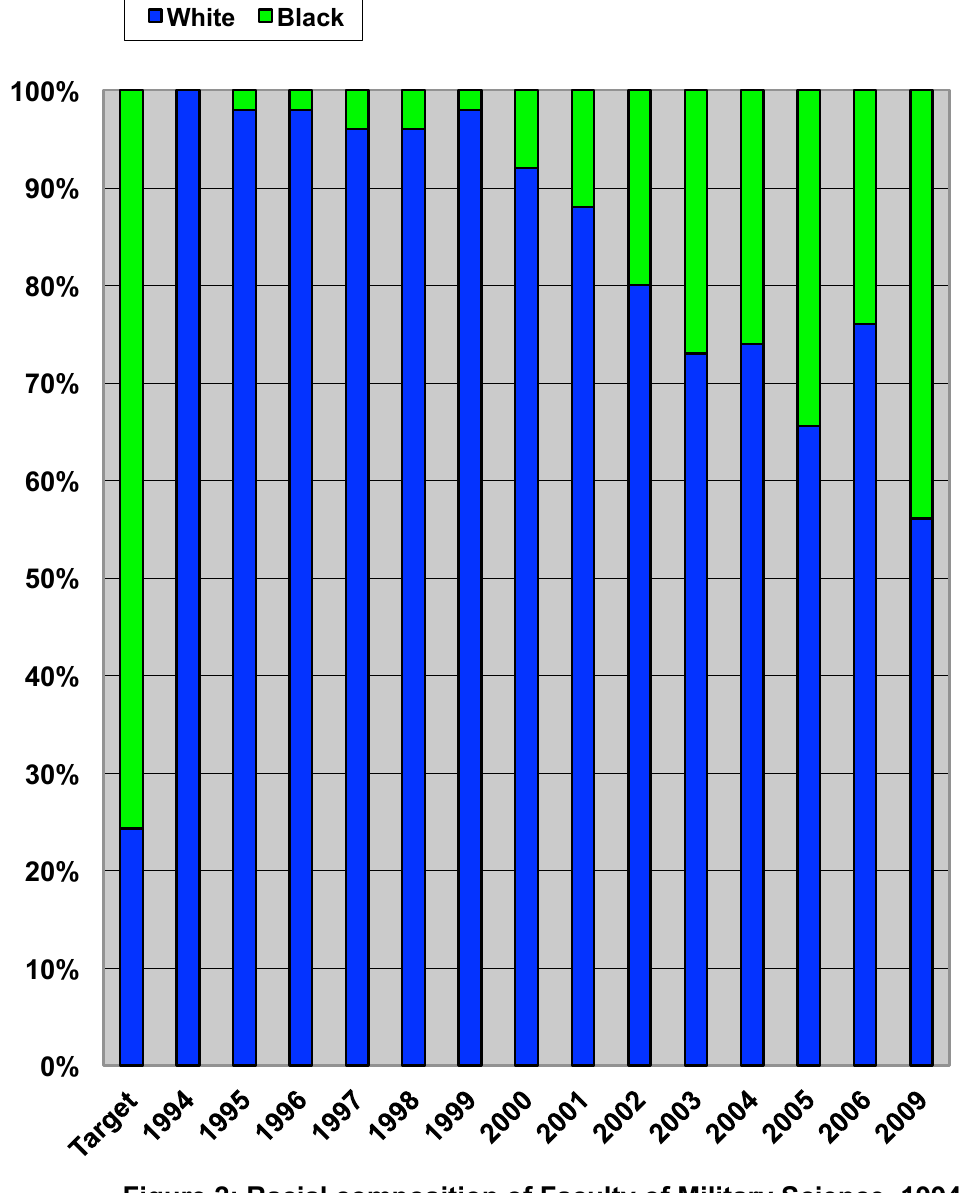
Figure 2: Racial composition of Faculty of Military Science, 1994 -